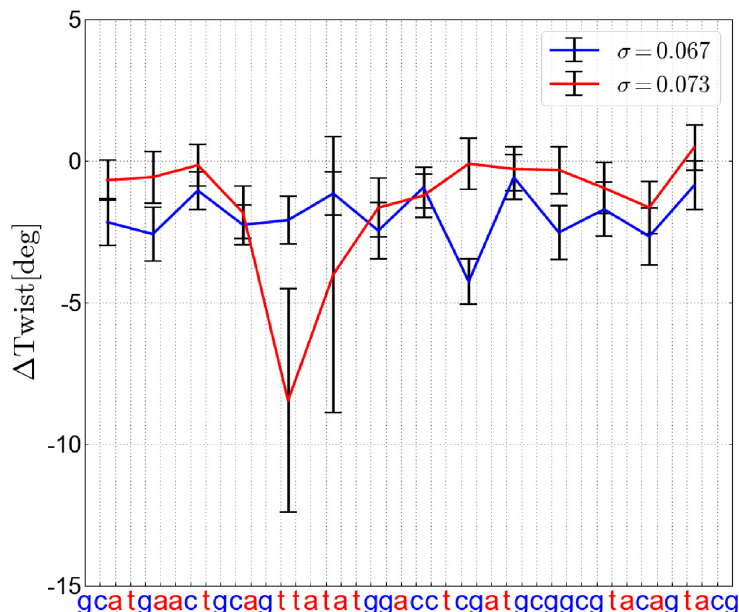
Fig 5. Average changes in twist at each base pair step (relative to unrestrained DNA, at-sequence) upon global unwinding for a superhelical stress σ slightly below melting (blue) and above melting in the TATA box segment (red line). The average deviations (with respect to fully relaxed unrestrained DNA) and standard deviations were calculated as averages of three adjacent base-pair steps.